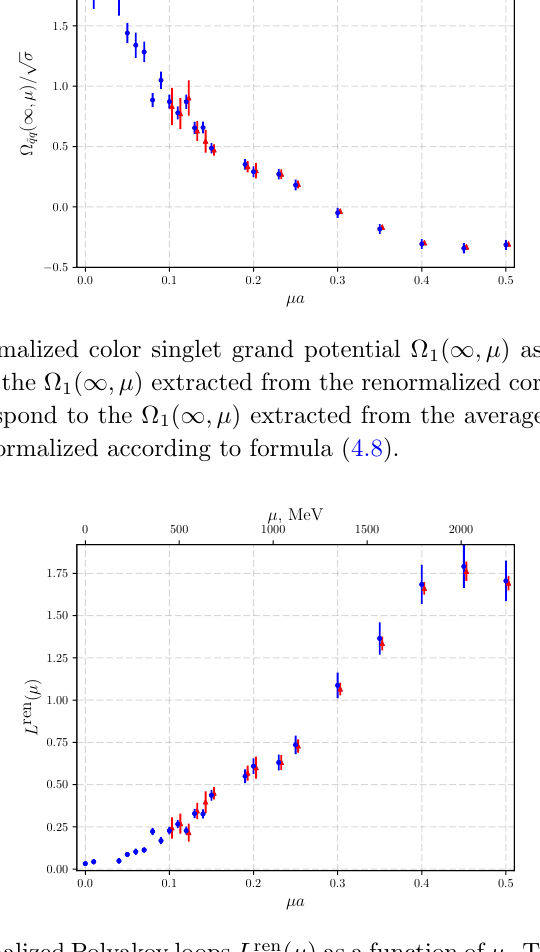
Figure 6 . The renormalized Polyakov loops L ren ( (cid:22) ) as a function of (cid:22) . The red triangles correspond to the L ren ( (cid:22) ) extracted from the renormalized correlators of Polyakov loops. The blue circles correspond to the average Polyakov loops measured on the lattice and renormalized according to formula